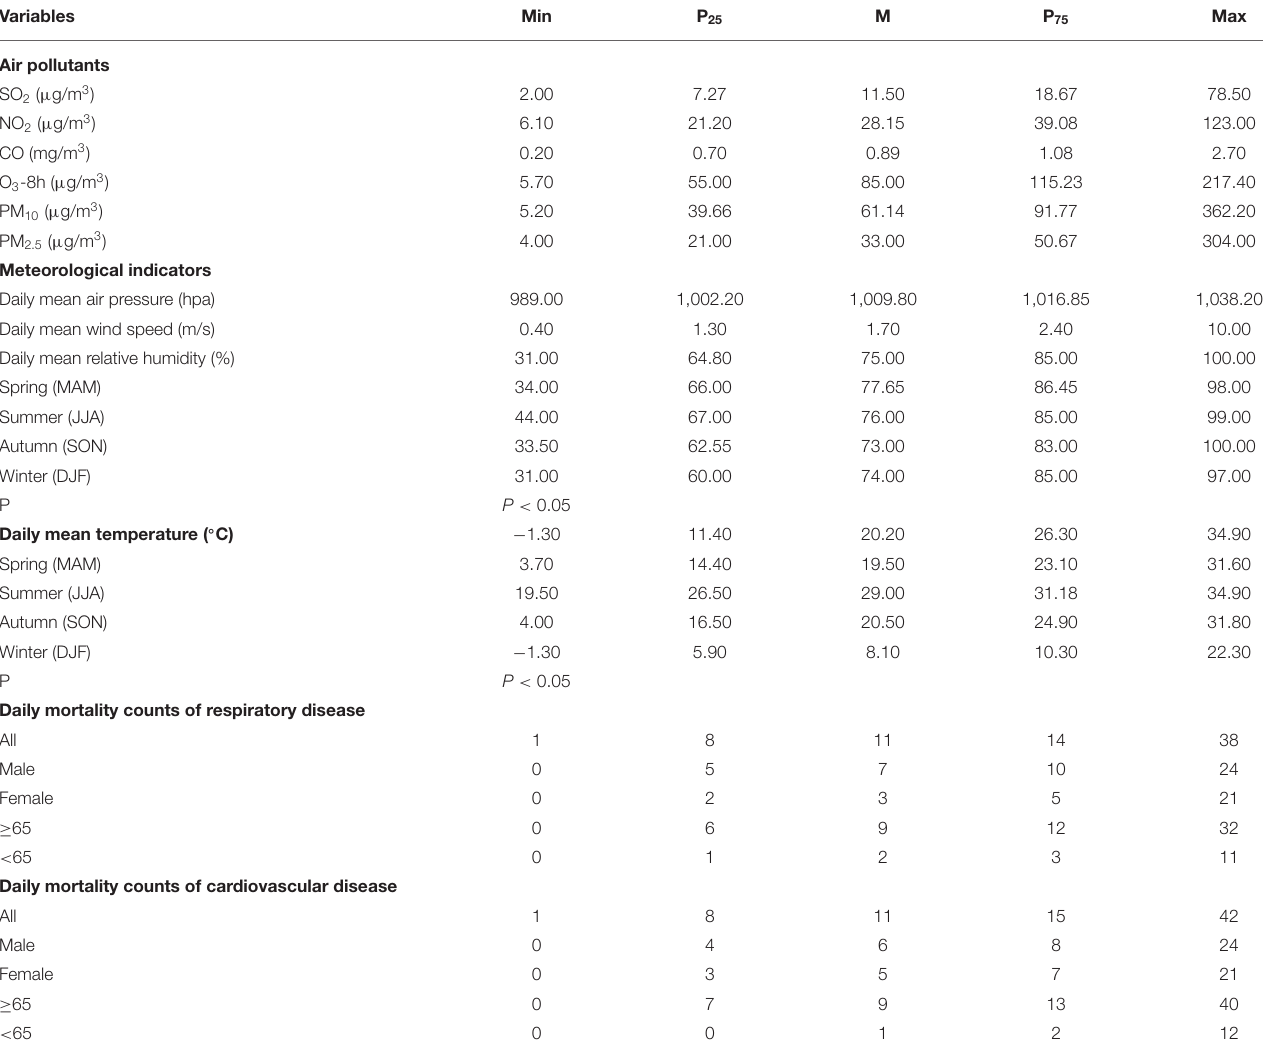
TABLE 1 | Distribution characteristics of air pollutants, meteorological indicators and non-accidental deaths in Nanchang City, 2014–2020. Variables